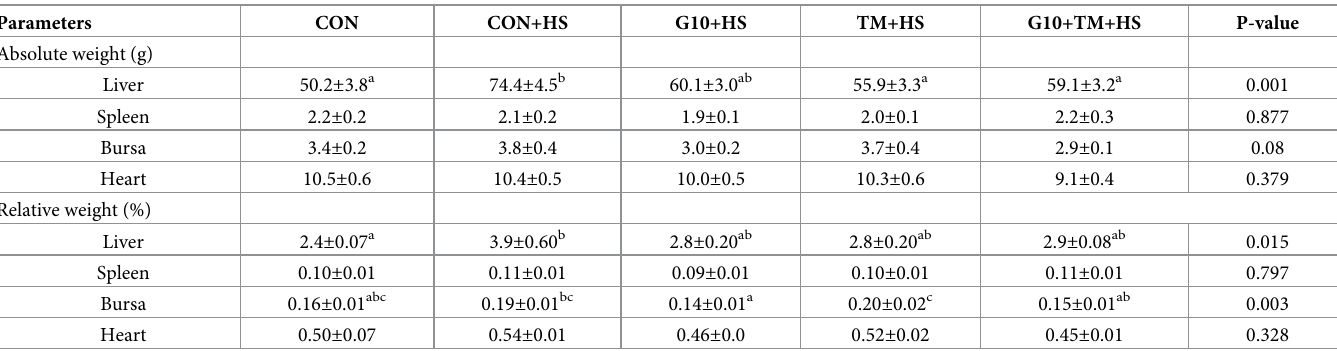
The treatments are described as follows: CON, chicks hatched from control eggs without in ovo injection and incubated at standard temperature; CON+HS, chicks hatched from control eggs without in ovo injection, incubated at standard temperature but exposed to HS; G10+HS, chicks hatched from eggs injected at 17.5 days of incubation with 0.6mL of 10% GABA dissolved in distilled water and exposed to HS; TM+HS, chicks hatched from thermally manipulated eggs exposed to 39.6˚C for 6 h daily from ED 10 to 18 and exposed to HS; G10+TM+HS, chicks hatched from eggs that received both previous treatments during incubation and exposed to HS. Data show mean ± SEM (n = 5). The P-values reported in the table are from the ANOVA procedure. Means with different superscripts (a, b or c) in the same row indicate significant differences by the Tukey test (P < 0.05).